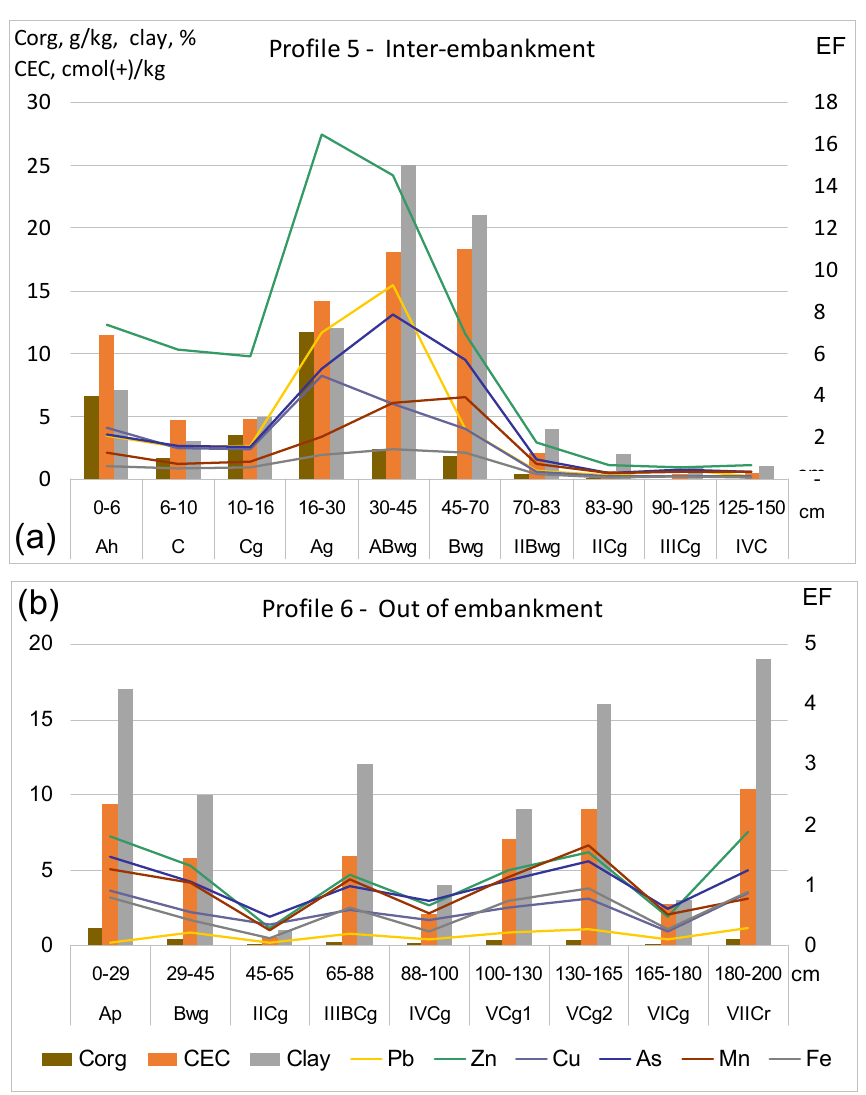
Figure 2. Distribution of metal(loid)s, against the background of crucial parameters of soil properties, in profiles 5 ( a ) and 6 ( b ), representative of the inter-embankment and out of embankment zones, respectively, in transect No. II. EF—enrichment factor calculated in relation to geochemical background; details are provided in the text.